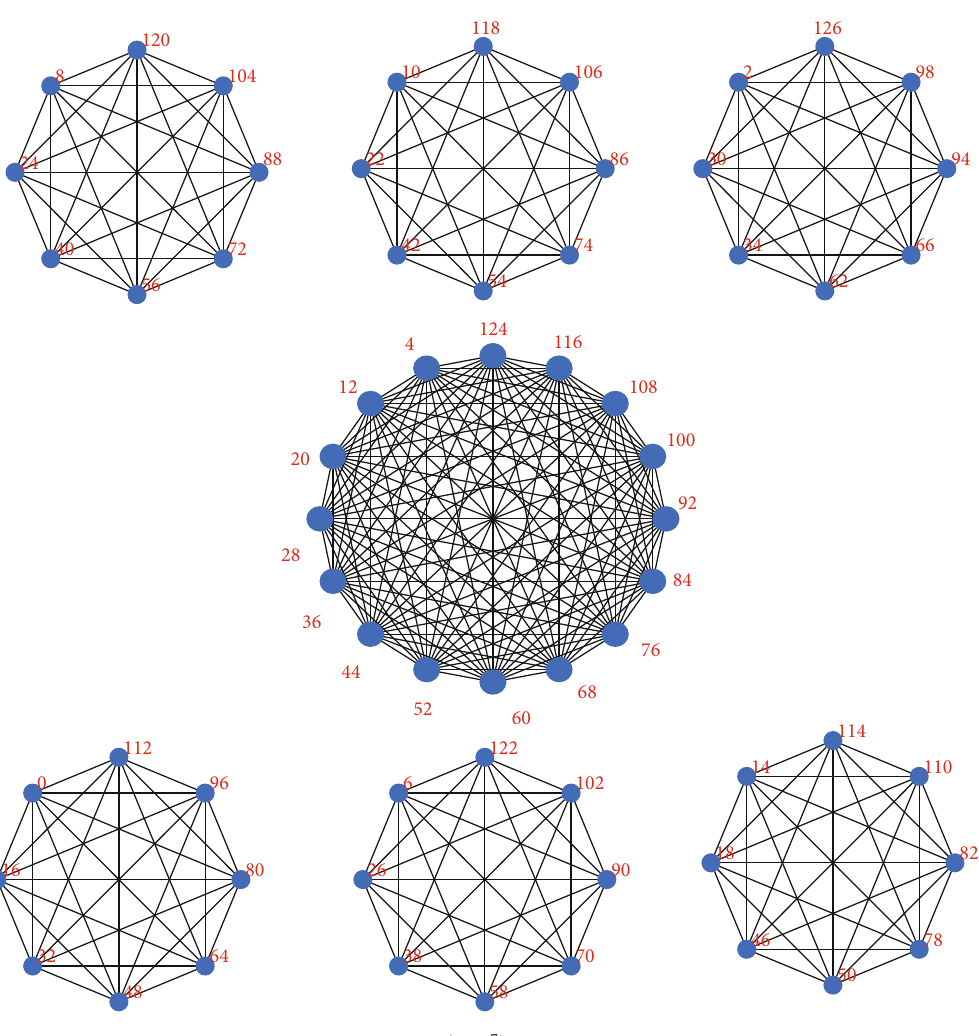
Figure 2: G ð 2, 2 7 Þ = 6 K